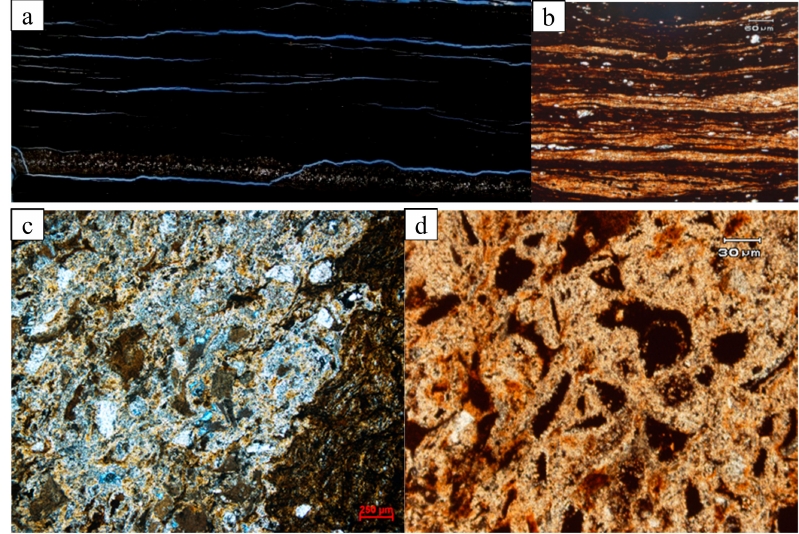
Figure 13. Cast slices. ( a ) Bedded reticulated cracks that developed in the argillaceous layer; ( b ) tu ff aceous lamina; ( c ) tu ff aceous debris and dissolved pore; ( d ) organic